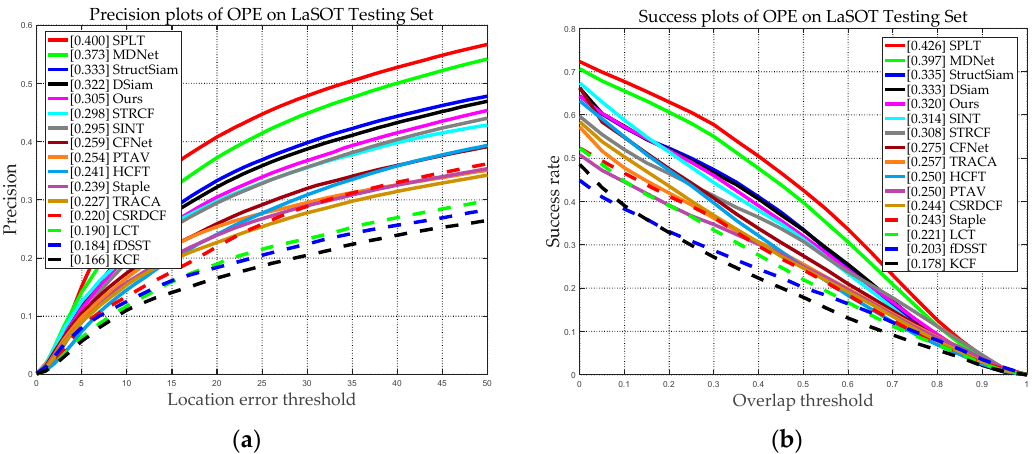
Figure 13. Precision and success plots on LaSOT using OPE. ( a ) Precision plots of OPE on LaSOT; ( b ) Success plots of OPE on LaSOT.